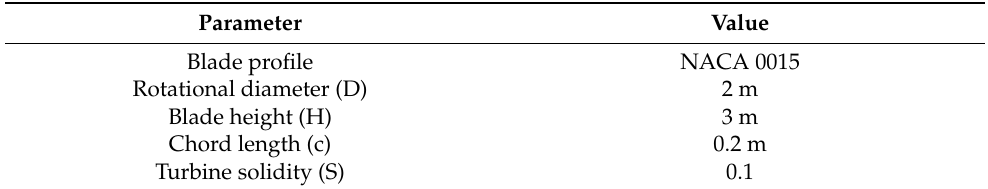
Table 1 summarizes the geometric features of an H-Darrieus rotor. Table 1. Geometry of the turbine rotor.